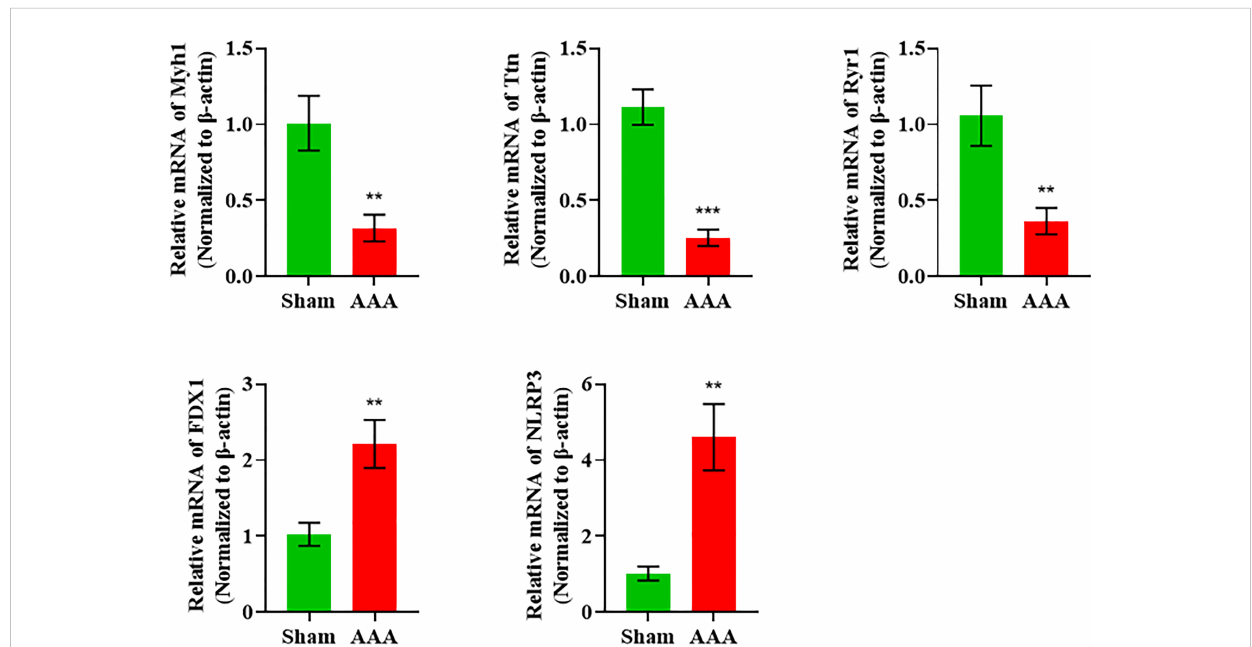
FIGURE 4 qRT-PCR validation of DElncRNAs and DEmRNAs in the AAA mice compared with matched tissues of sham-operated mice. **p value < 0.01, ***p value <